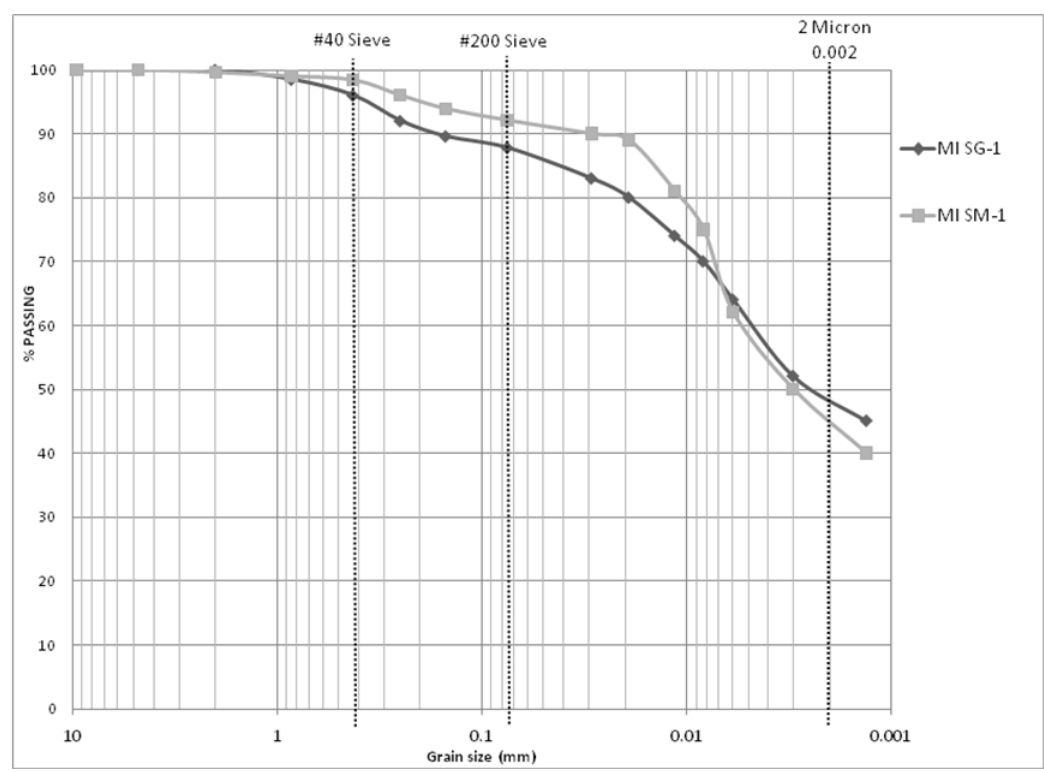
Figure 7. Comparison of grain size distributions: manually processed vs . grinder processed stockpiled samples of mined clay from Southwest Michigan (MI SM-1 & MI